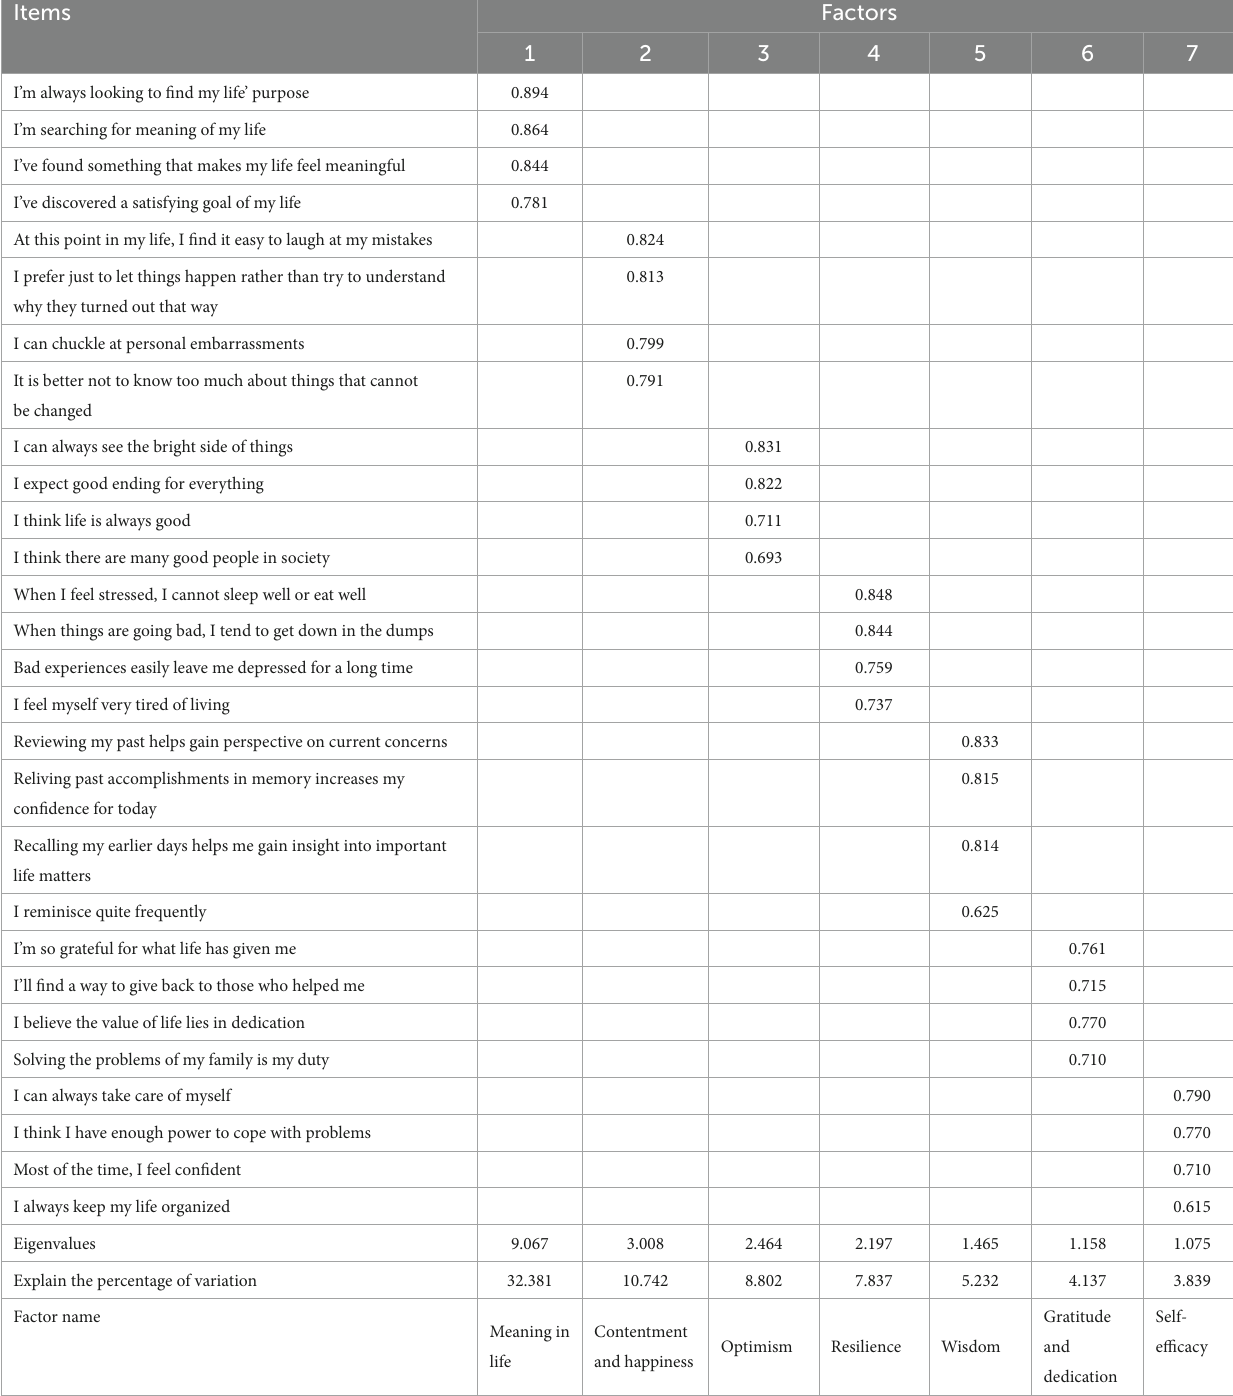
TABLE 3 Results of the principal components analysis of 28 items (N = 198).